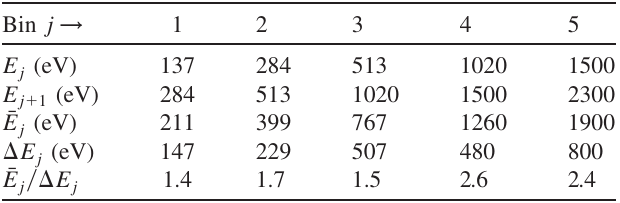
TABLE II. Resolution bins for response functions R (Fig. 1) as estimated by the Backus-Gilbert method